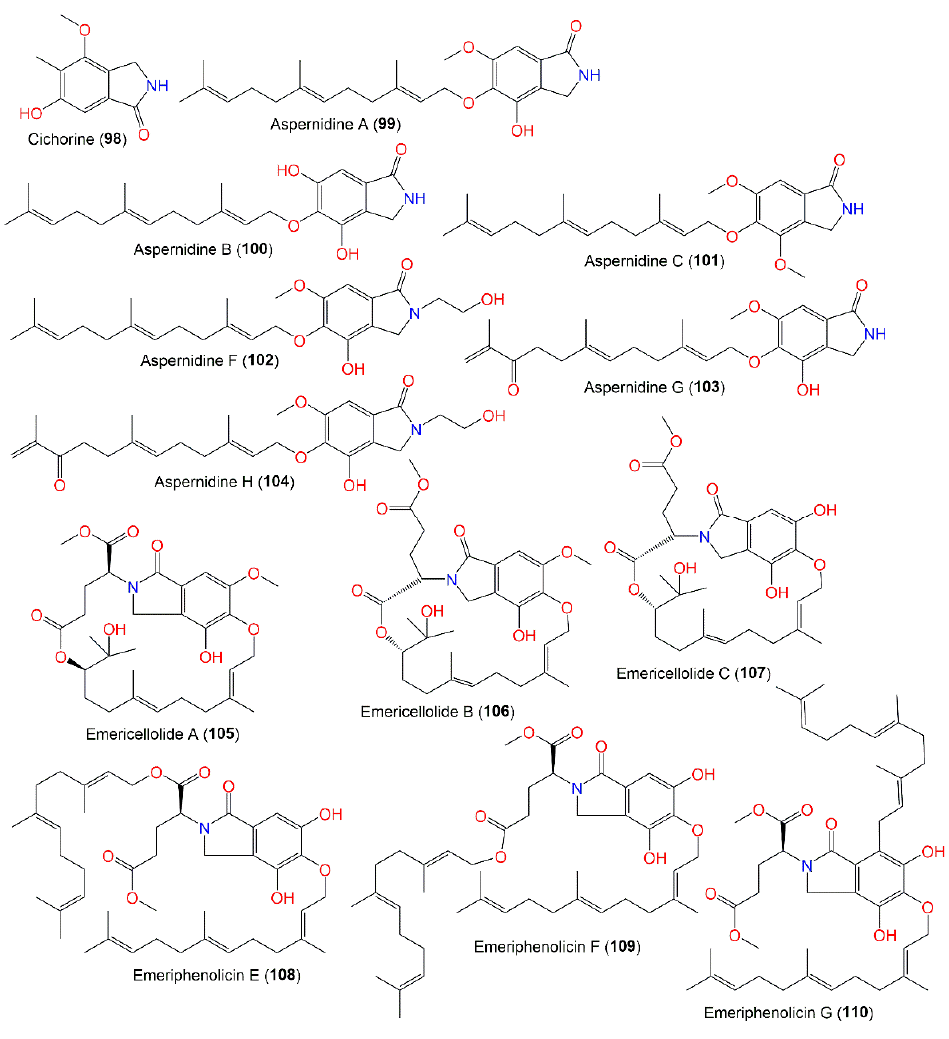
Figure 9. Structures of isoindole ( 98 – 110 ) alkaloids. Table 7. Indole and isoindole alkaloids reported from A. nidulans .